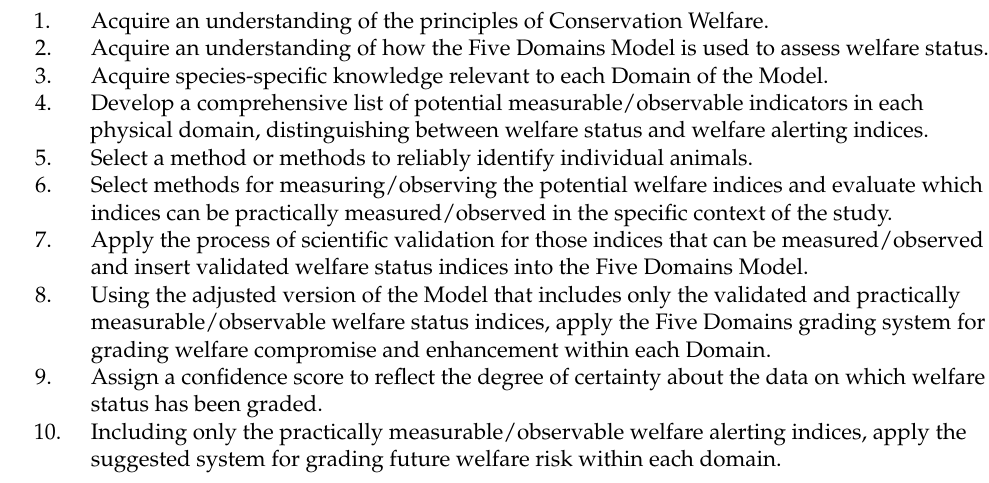
Table 1. The Ten-Stage Protocol for assessing the welfare of non-captive wild animals